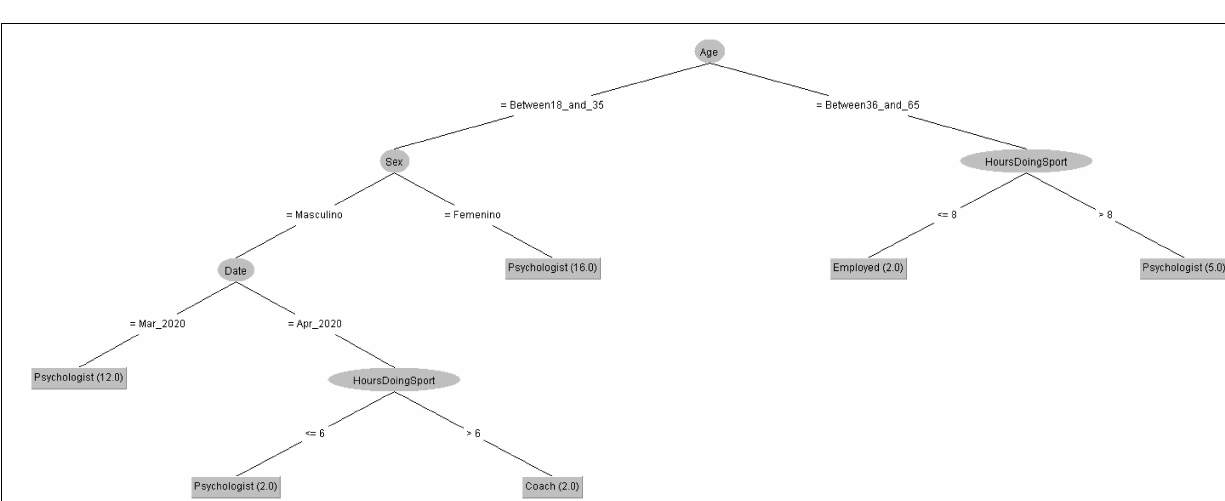
significate one. Each cluster also shows the number of people belonging to it and the per cent it represents.